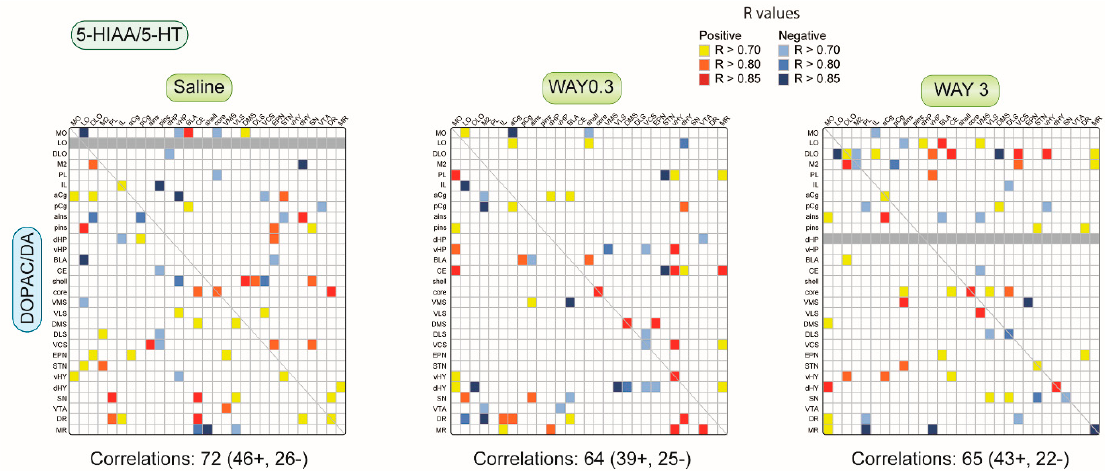
Figure 4. Correlative analysis between the 5-HT turnover (5-HIAA / 5-HT ratio) and DA turnover (DOPAC / DA ratio) across rat brain regions. Representation of the range of Pearson’s r values for each linear regression of 5-HIAA / 5-HT ratio (top horizontal) versus DOPAC / DA ratio (left vertical) within and between the 29 brain areas in saline (first column), WAY-163909 0.3 mg / kg (second column) and 3 mg / kg (third column) treated rats. Colored boxes correspond to the existence of a significant correlation between the two parameters (yellow to red: positive; blue: negative) considered after correction for multiple comparisons. The grey boxes indicate that these correlations were not performed due to the low number of values (see Table S1).